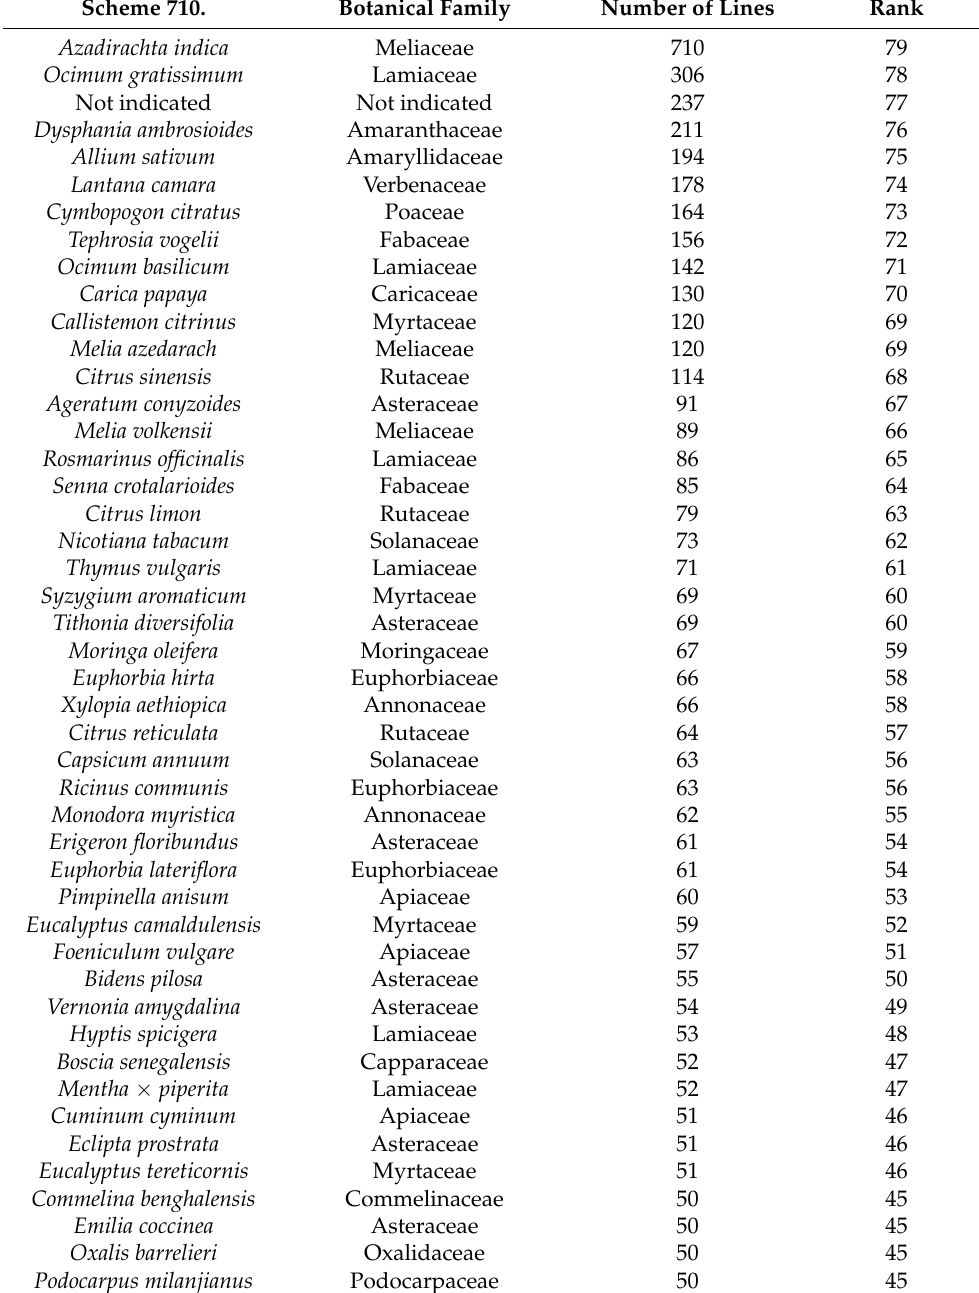
Table 4. Ranking of plant species used in plant health (extract from Table S1) according to their occurrence (=number of lines = knowledge) in